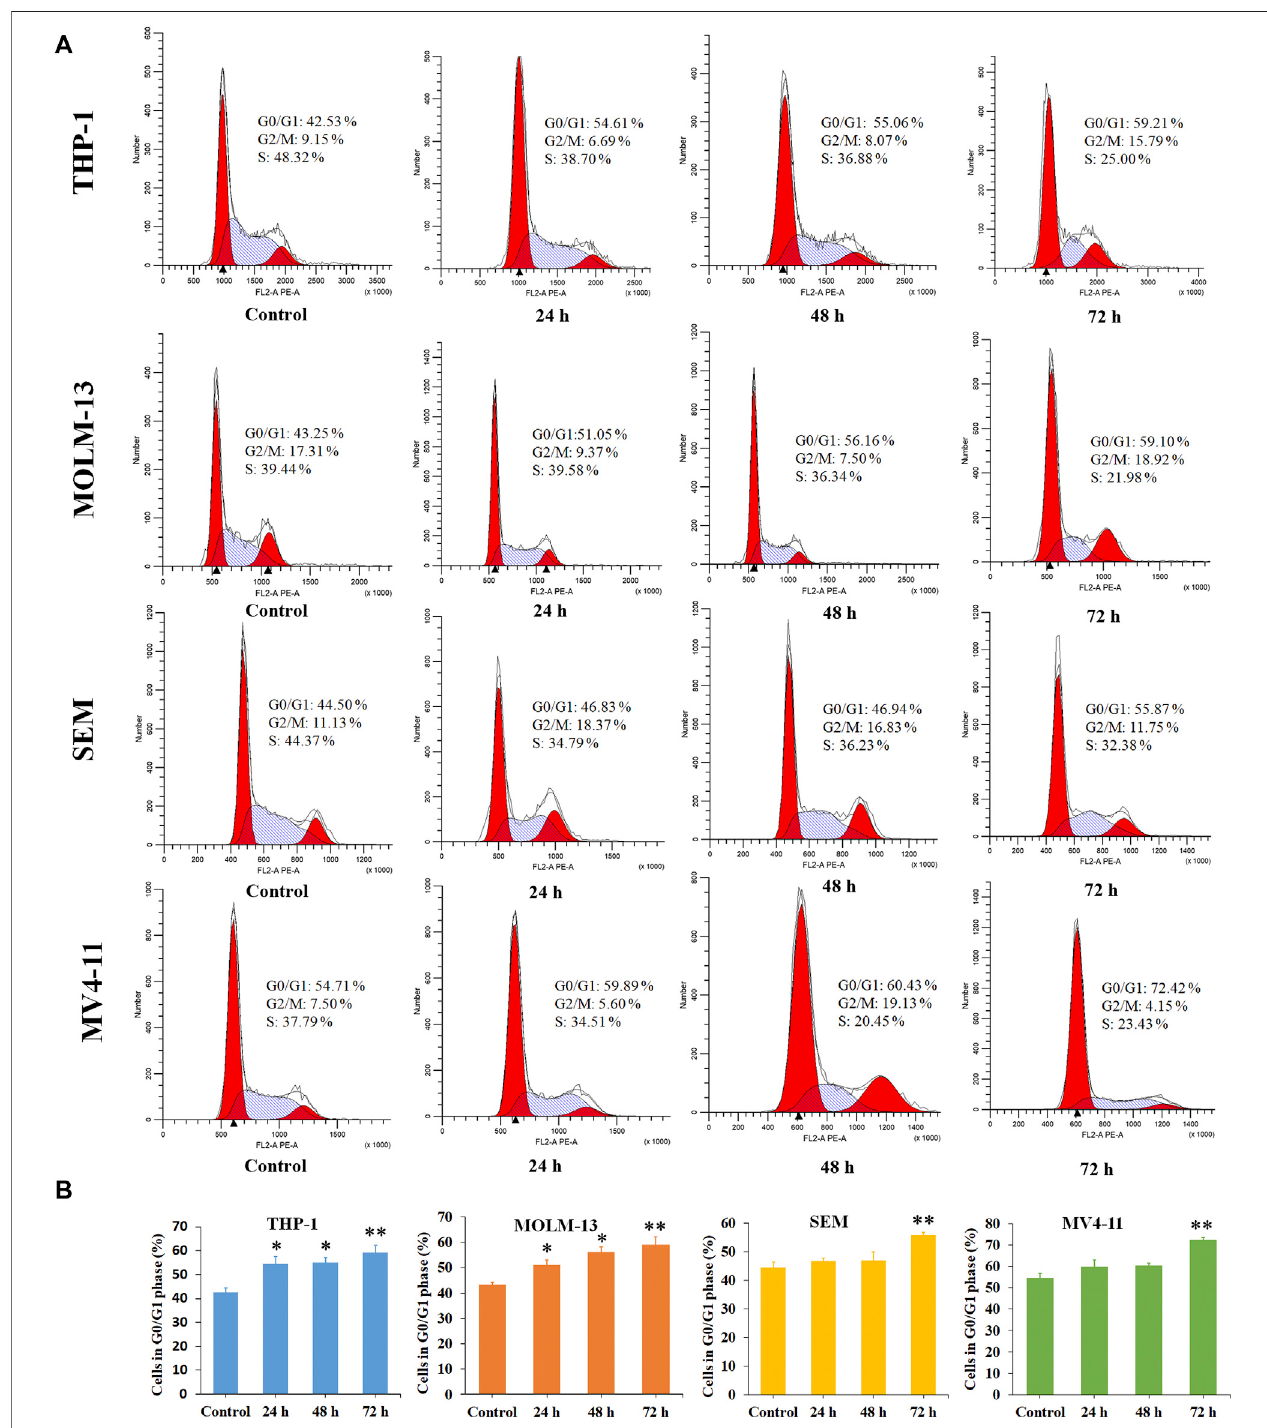
FIGURE 5 | Molecule P6 induces cell cycle arrest in THP-1, MOLM-13, SEM and MV4-11 cells. (A) Cells were treated with 1.0 (THP-1, MOLM-13 cells) and 2.0 (SEM and MV4-11 cells) µM of P6 for 72 h, then fl ow cytometry was used to detect the percentage of cells in various phase of the cell cycle. (B) Graph illustration of the cell proportion in G0/G1 phase (* p < 0.05, ** p < 0.01).